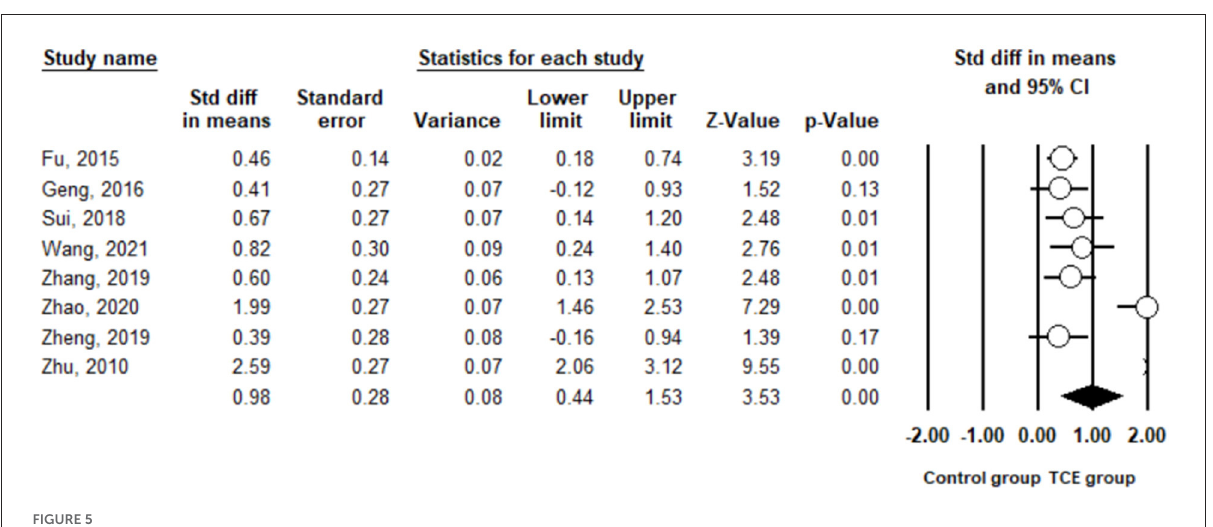
Sleep quality was measured using the PSQI in the three included studies (32, 36, 37). The pooled results indicated that